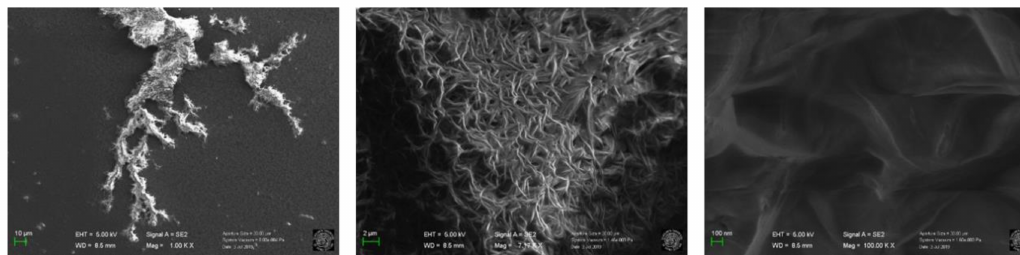
Figure 1. HR-TEM images of the amorphous and graphitic carbon dots (CDs).